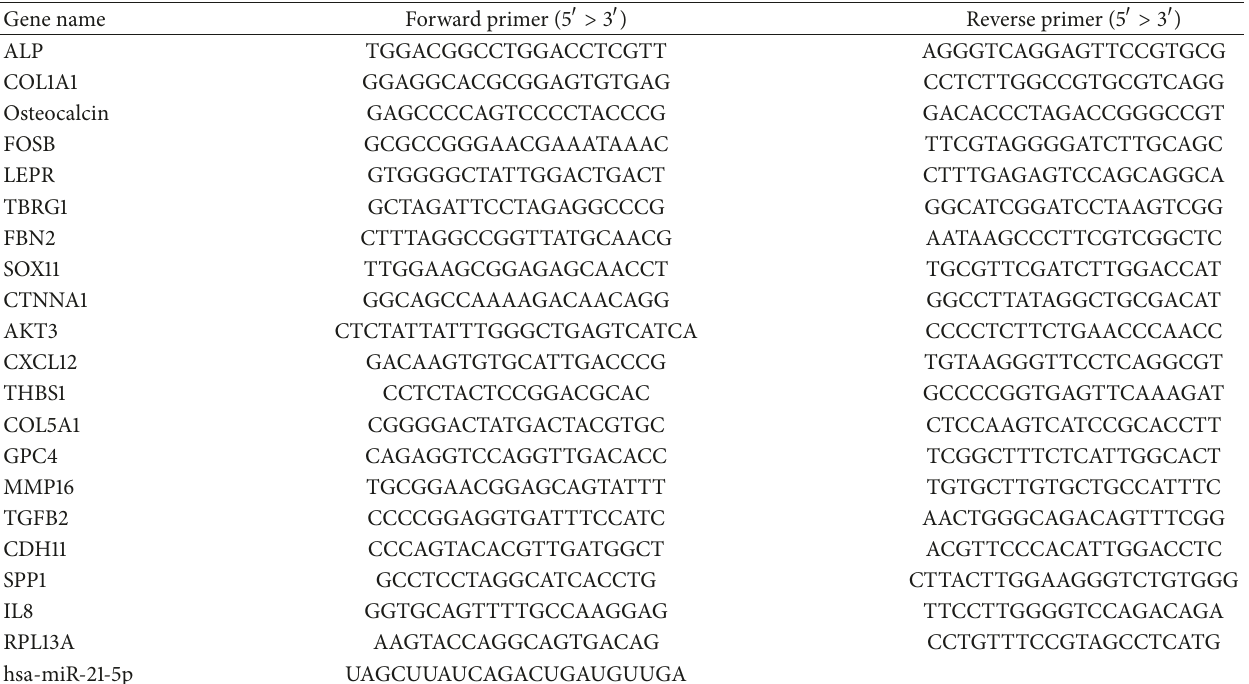
Table 1: Primers used in this